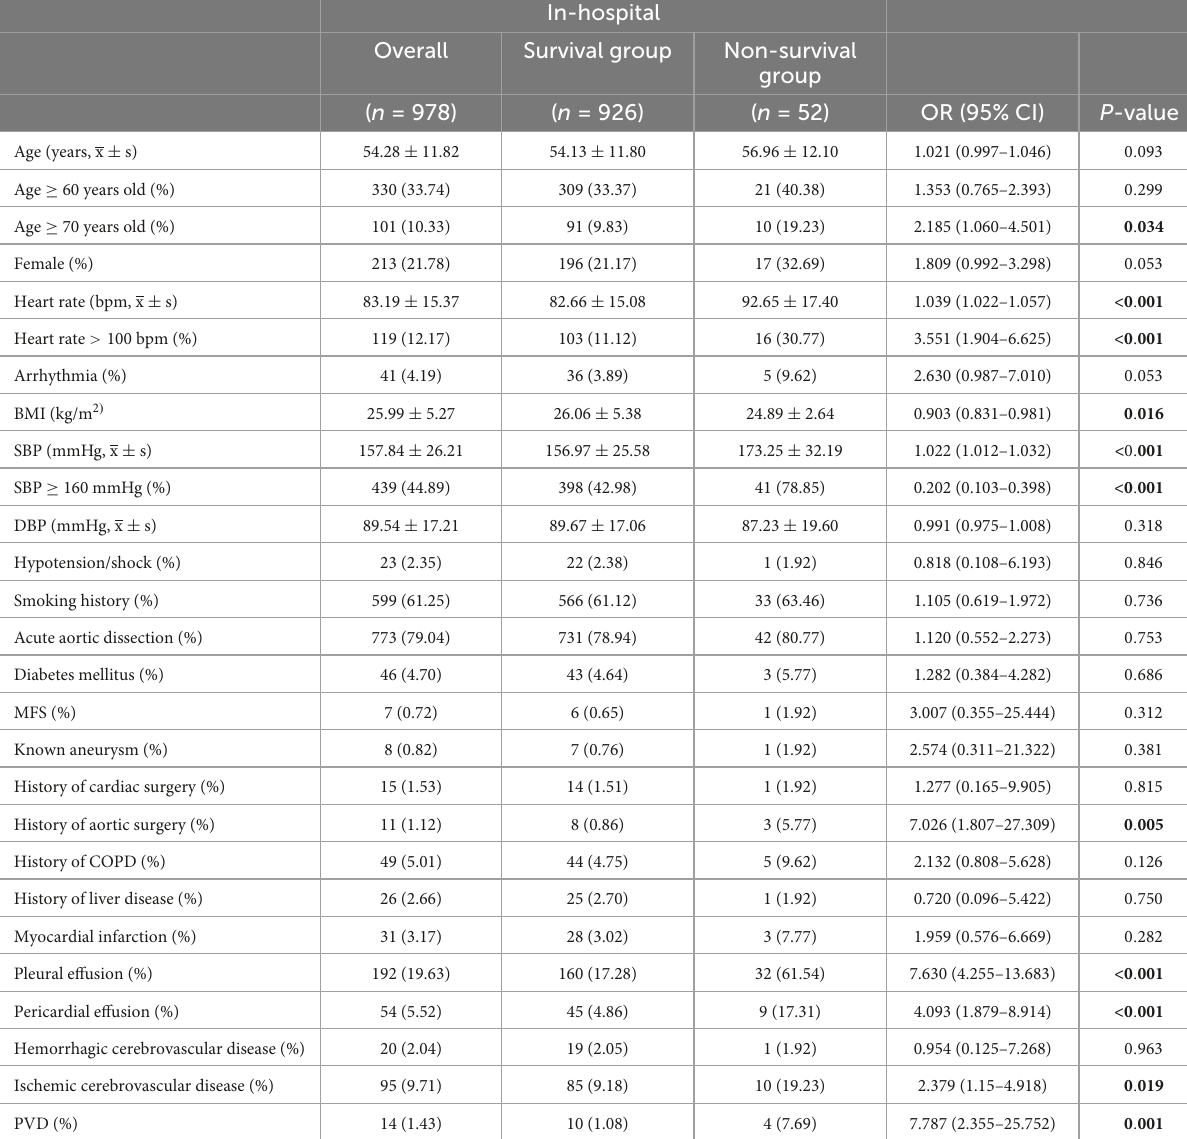
TABLE 1 Demographics and patient history of all patients with Stanford type B aortic